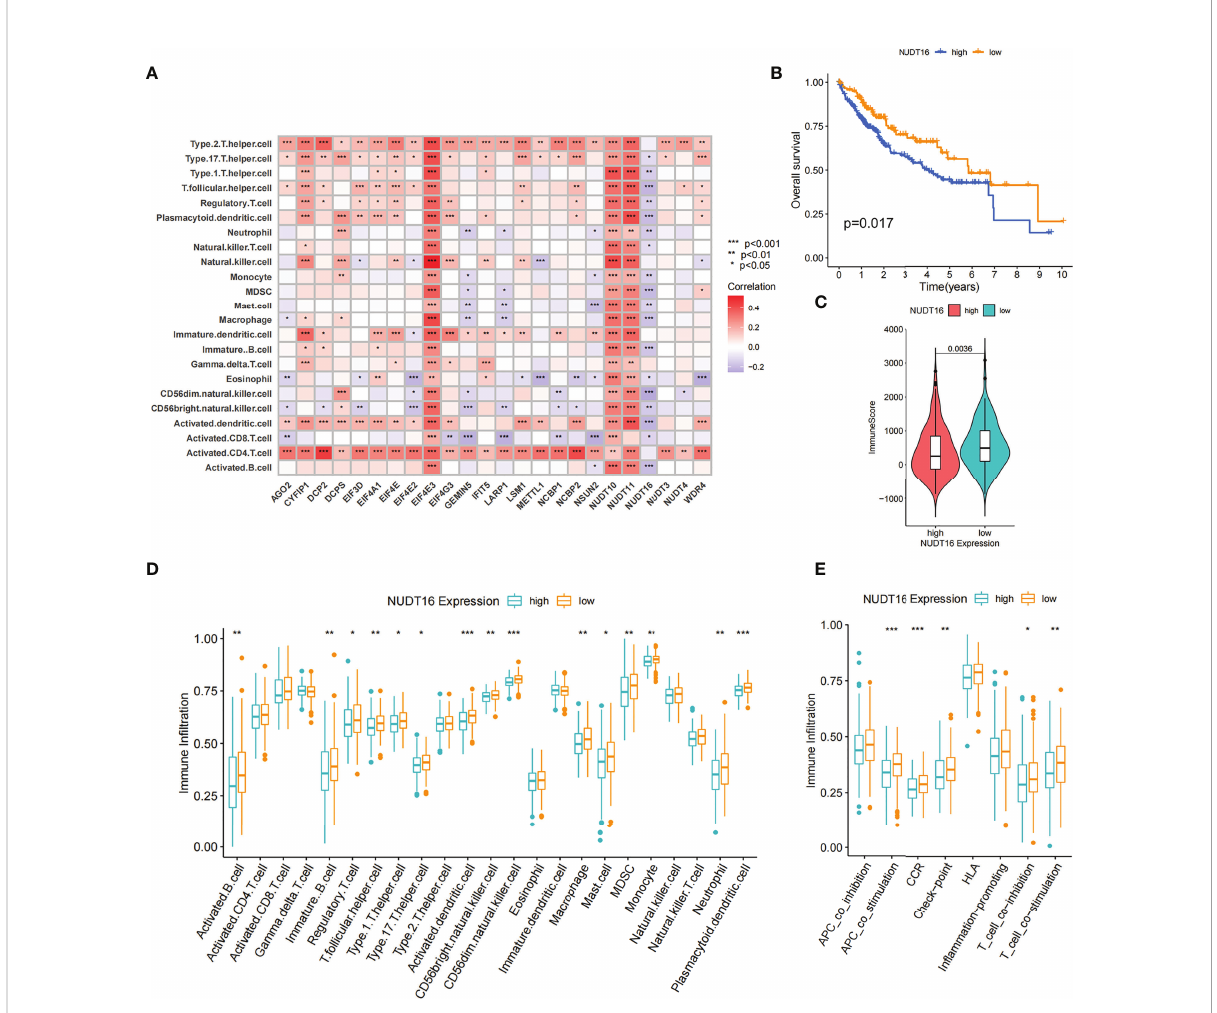
FIGURE 5 Correlation of TME in fi ltration with m 7 G regulators and the role of NUDT16 in hepatocellular carcinoma. (A) The correlation between each immunocyte and individual m 7 G regulators was analyzed by spearman analysis. (B) Overall survival was analyzed using Kaplan-Meier curves for high and low NUDT16 expression subgroups. (C) Distribution of immune scores in high and low NUDT16 expression subgroups. (D) Comparison of the differences of individual immunocytes between the high and low NUDT16 expressing subgroups. (E) Comparison of the differences in immune-related functional levels between high and low NUDT16 expressing subgroups. Asterisks represent statistical p-values (*P < 0. 05; **P < 0. 01; ***P < 0.